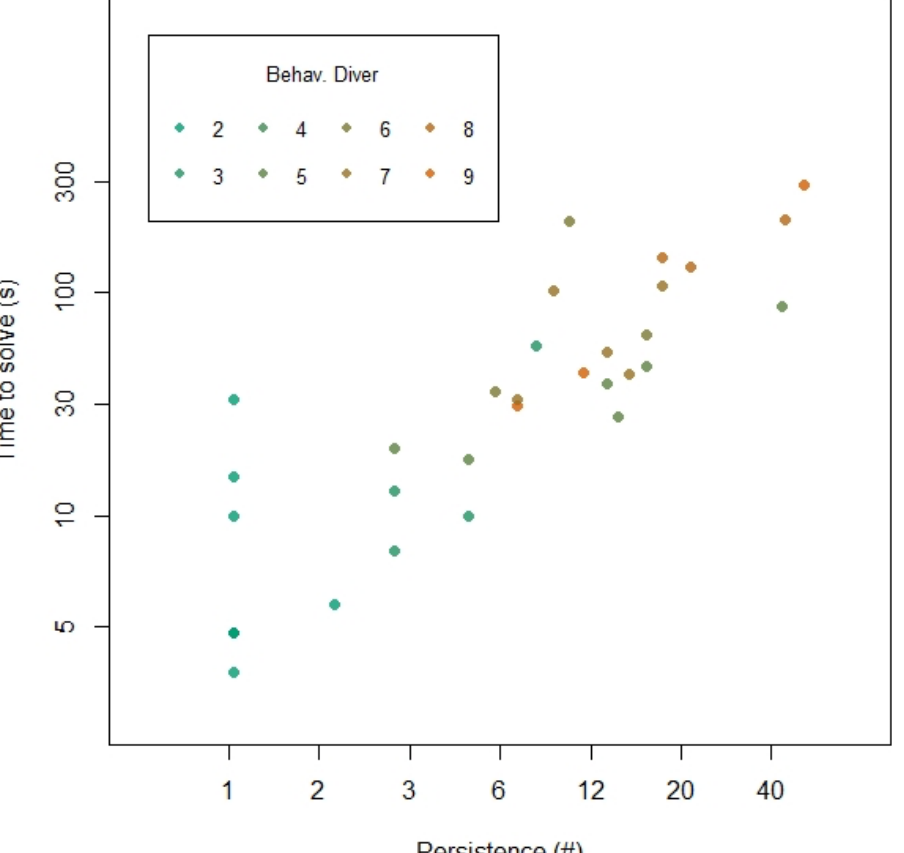
The Influence of Persistence and Behavioral Diversity on Time-to-Solve